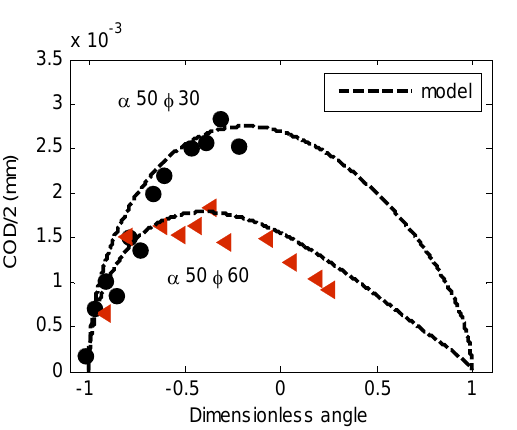
Figure 11: t = 3.4mm; crack length 2  (  0°) and (  0°).